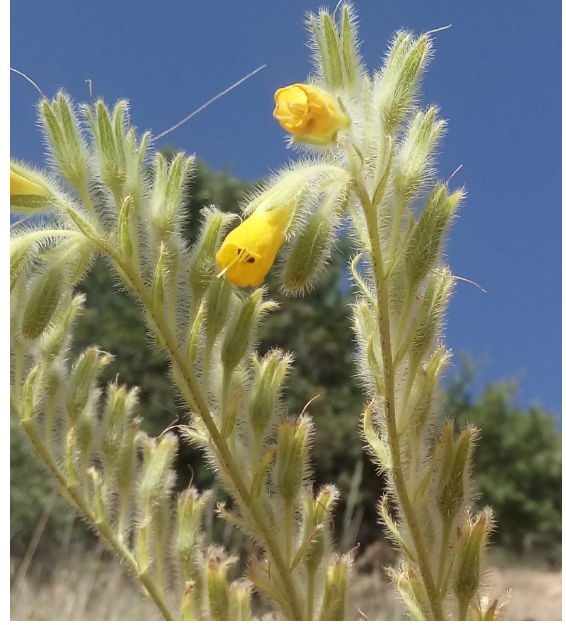
Figure 5. Onosma nervosa with purplish to black spots.